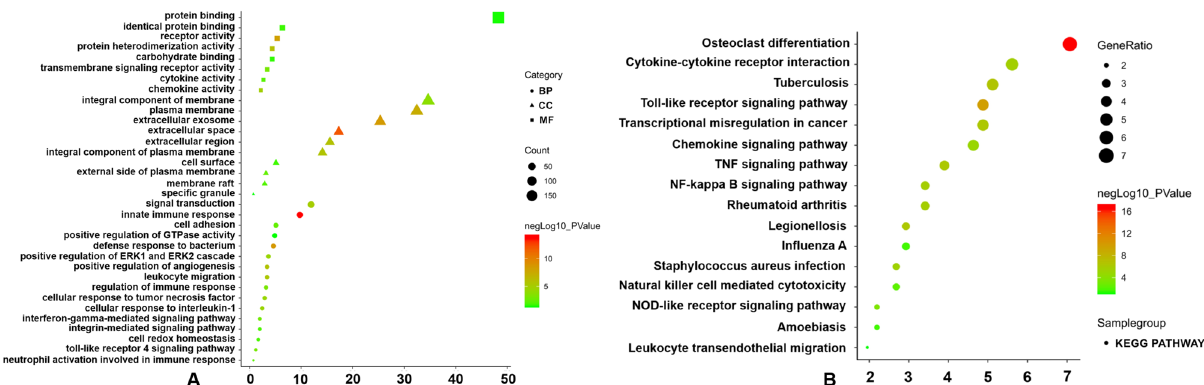
Figure 5. GO functional and KEGG pathway enrichment analyses for genes in the object module. The x-axis shows the number of genes and the y-axis shows the GO and KEGG pathway terms. The − log10 (P-value) of each term is colored according to the legend. ( A ) GO functional enrichment analysis. ( B ) KEGG pathway enrichment analysis 64